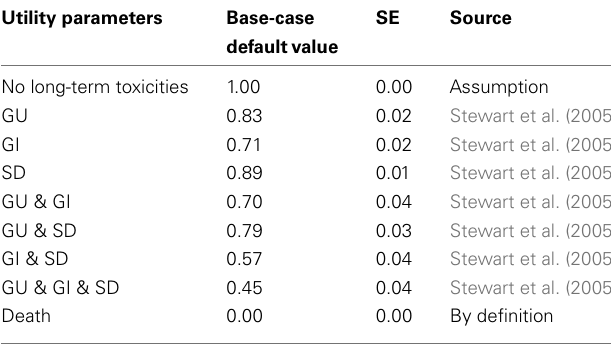
Table 3 | Model utility inputs.